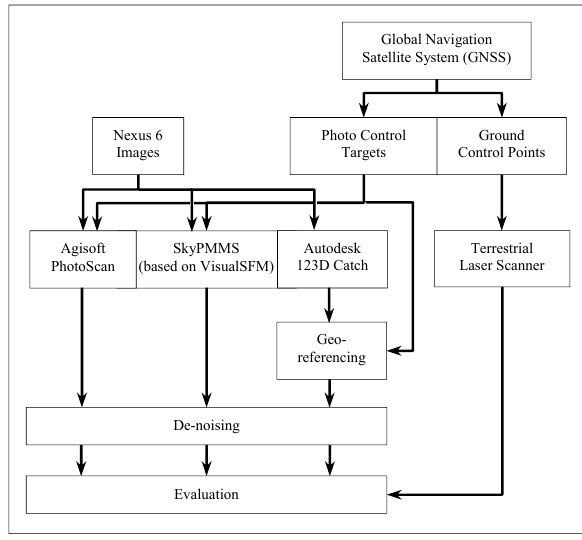
Figure 4. Methodology flowline adopted in this